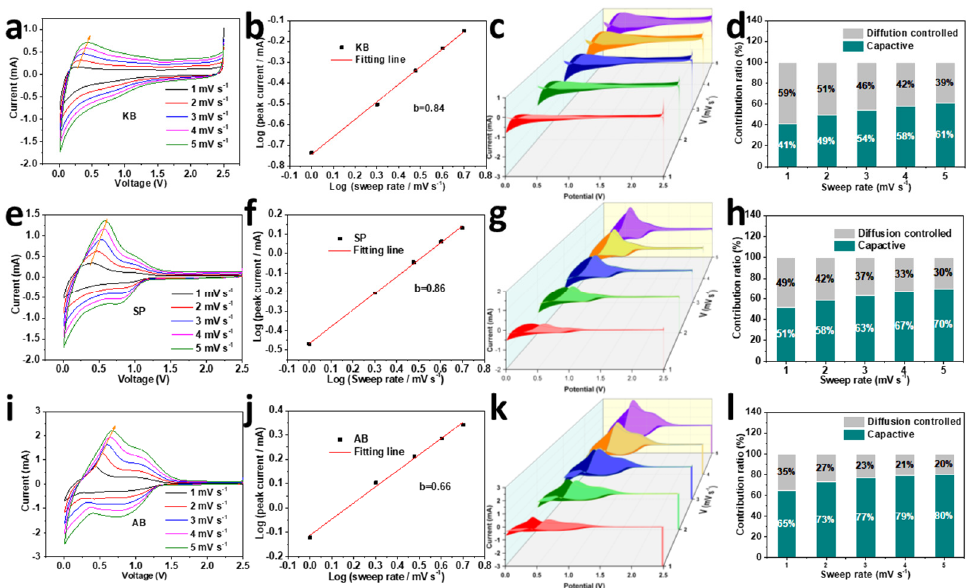
Figure 7. Behaviors of pseudocapacitance in silica aerogels using KB ( a – d ), SP ( e – h ), and AB ( i – l ) as conductive agents.